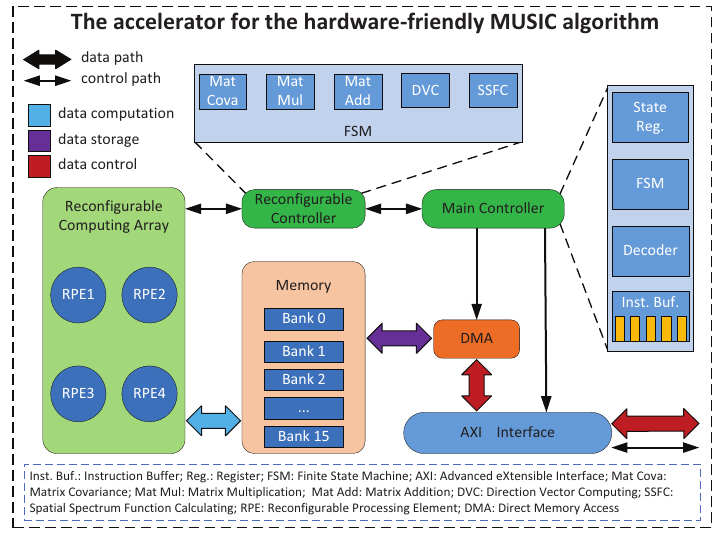
Figure 1. The architecture of the